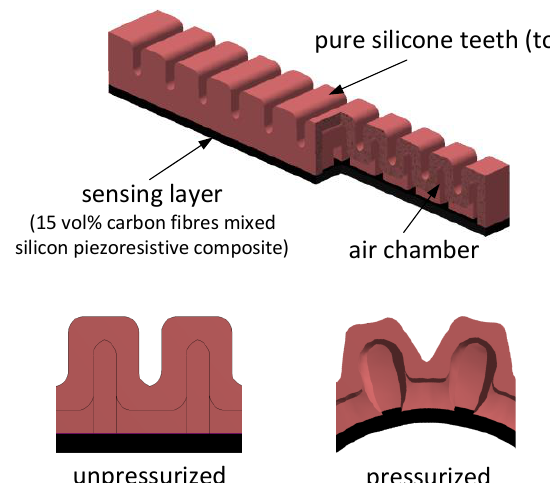
Figure 1. Design of a soft self-sensing finger actuator; the soft finger consists of an upper pure silicone teeth layer and a lower carbon fibre rich composite layer fabricated using 15 vol% carbon fibres mixed with silicone to create the piezoresistive composite.